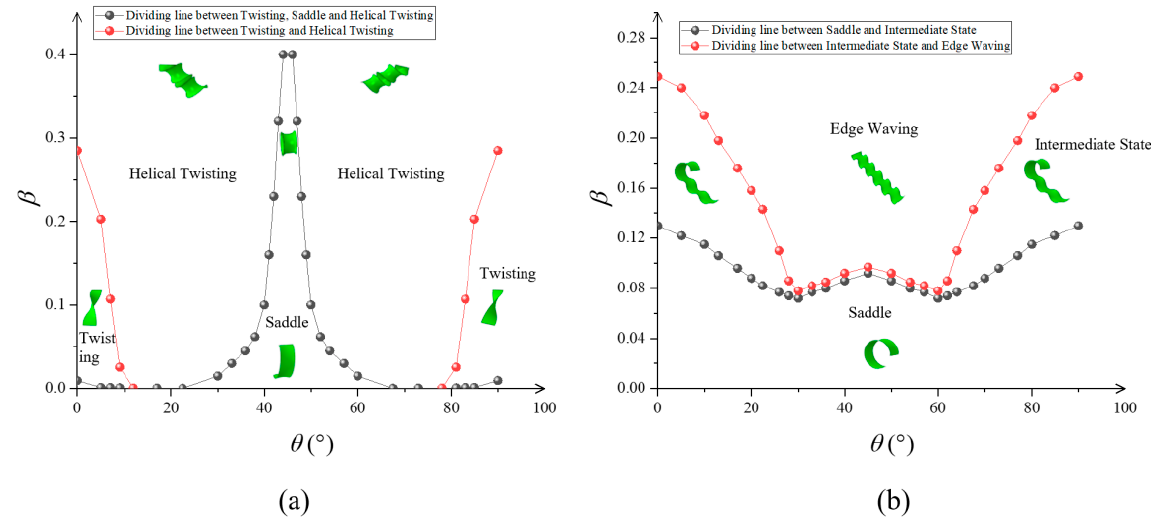
Figure 7. Variation in the rear flexion pattern with off-axis angle θ .